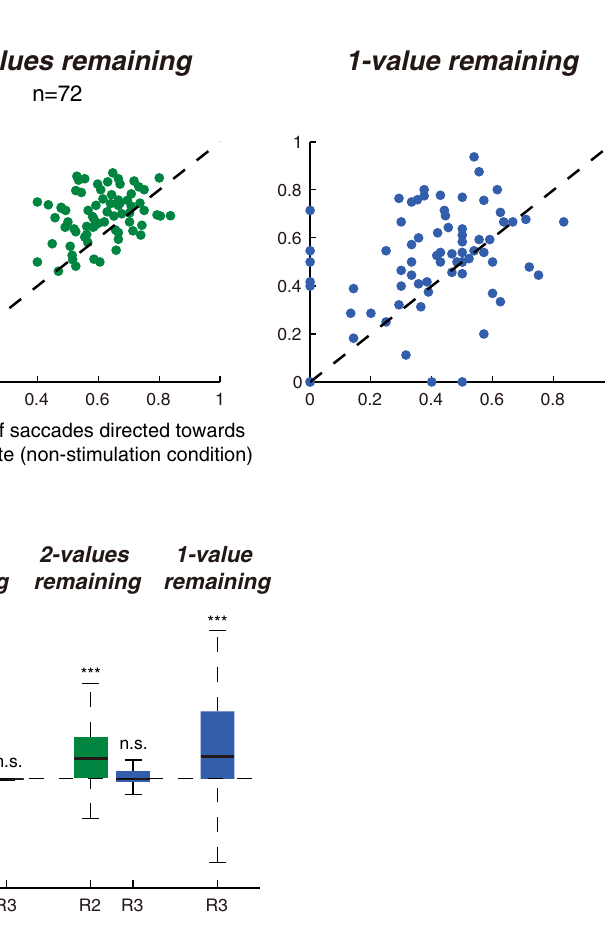
Fig. 7 Sub-threshold micro-stimulation applied during the late fi xation period biased choice. a The proportion of choices directed toward the stimulation site target in stimulation condition vs. non-stimulation control condition across the 3 menus. Purple, green, and blue denote when 1st, 2nd, and 3rd value ranking targets were located at the stimulation site, respectively. The dashed line represents the line of unity. b Difference in the proportion of saccades directed toward the stimulation site under stimulation condition minus non-stimulation condition. All the 72 blocks in stimulation experiments were included. Wilcoxon signed-rank test, two-sided, from left to right, P = 3.2 × 10 − 10 , 8.7 × 10 − 8 , 0.90, 1.2 × 10 − 6 , 0.28, and 1.3 × 10 − 4 , respectively. Source data are provided as a Source data fi le. For the boxplots, on each box, the central mark is the median, the edges of the box are the 25th and 75th percentiles, and the whiskers extend to the most extreme data points that the algorithm considers not to be outliers. Outliers are data points that are larger than Q3 + 1.5 × (Q3 – Q1) or smaller than Q1 – 1.5 × (Q3 – Q1), where Q1 and Q3 are the 25th and 75th percentiles,